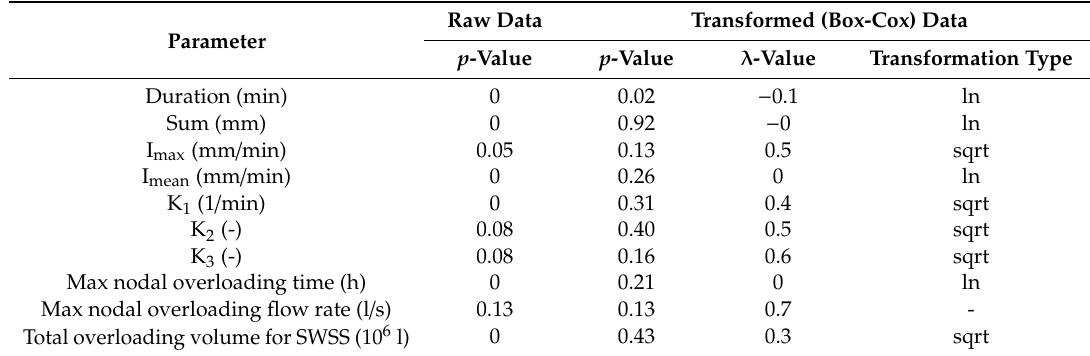
Table 8. Results of the Shapiro–Wilk test ( p -value) before and after Box-Cox data transformation.